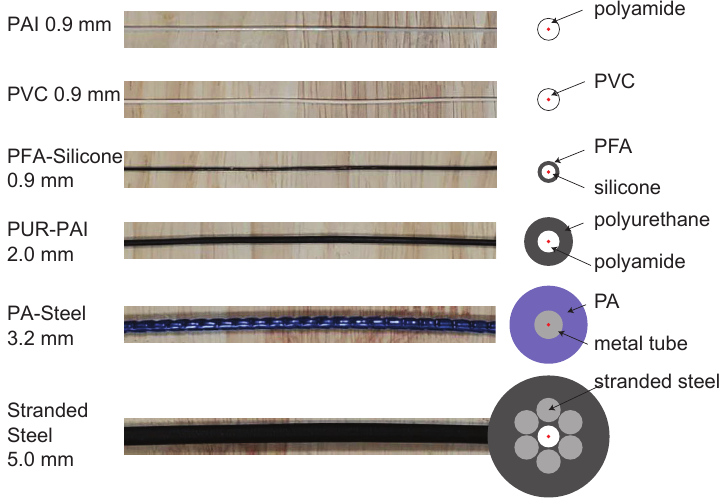
Figure 2. Cables used in the current test campaign